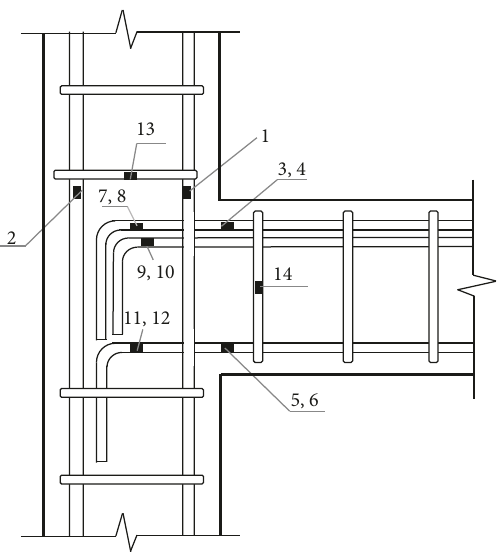
Figure 7: Location of strain gauges in